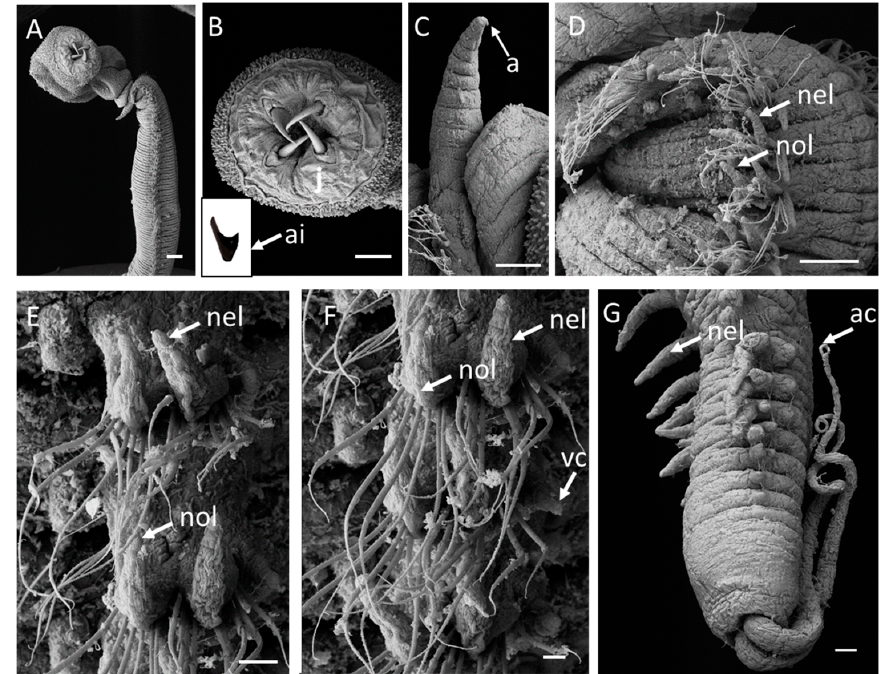
Figure 3. Glycera sheikhmujibi n. sp. scanning electron microscope (SEM) images of the ( A ) anterior lateral view, ( B ) terminal ring of the jaws, ( C ) enlarged view of prostomium, ( D ) anterior chaetigers, ( E ) mid-body chaetigers, ( F ) lower mid-body chaetigers, and ( G ) posterior chaetigers. ai: aileron, j: jaw, a: antenna, vc: ventral ciri, nol= notopodial lobe, nel= neuropodial lobe, ac: annul ciri; scale bars: A and B = 200 µm, C and D= 100 µm, E = 20 µm, F = 10 µm, G = 20 µm.